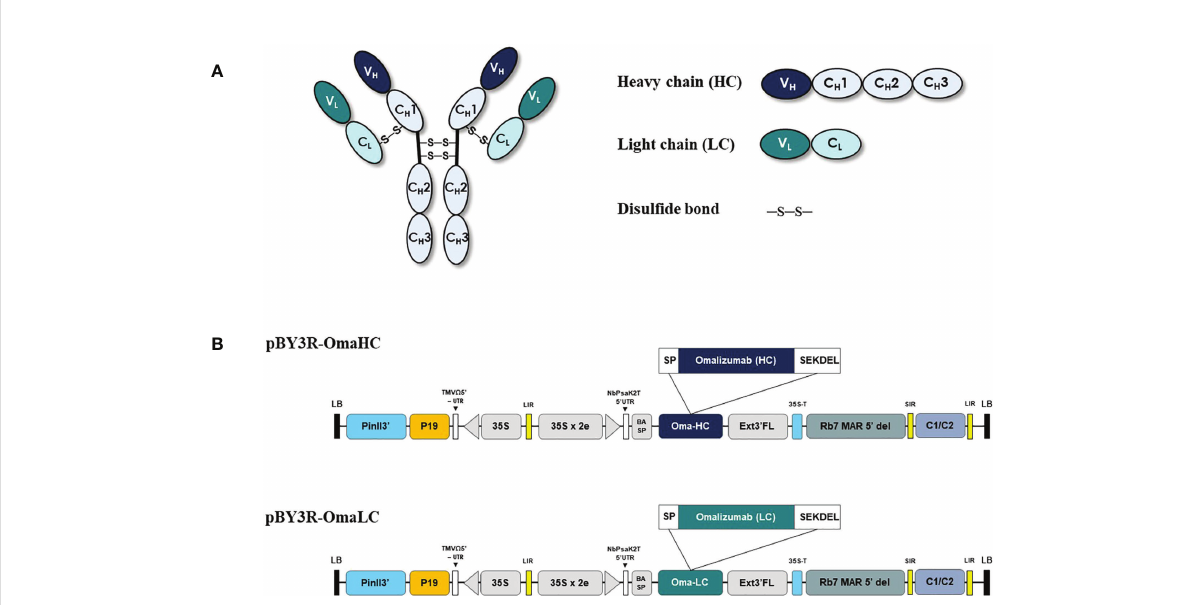
FIGURE 1 Schematic representation of pBY3R vector used in the present study for expression of anti-human IgE antibody (Omalizumab). (A) Schematic and structural elements of heavy chain (HC), light chain (LC) of codon optimized Anti-IgE antibody for expression in plant host and assembled plant produced anti-IgE mAb. (B) T-DNA region of the pBY3R vector; P35S: cauli fl ower mosaic virus (CaMV) 35S promoter; NbPsaK2T 5 ’ UTR: 5 ’ untranslated region; BASP: barley a -amylase signal peptide; Oma-HC: anti-IgE antibody heavy chain; Oma-LC, anti-IgE antibody light chain; Ext3 ’ FL: Full length of the tobacco ( Nicotiana tabacum ) extension gene; 35 S-T: CaMV 35S terminator l; Rb7 MAR 5 ’ del: tobacco RB7 promoter; SIR: short intergenic region of BEYDV genome; LIT: long intergenic region of BeYDV genome; C2/C1: bean yellow dwarf virus (BeYDV) open reading frames C1 and C2 encoding for replication initiation protein (Rep) and RepA; P19: P19 gene from tomato bushy stunt virus (TBSV); PinII 3 ’ : terminator from potato proteinase inhibitor II